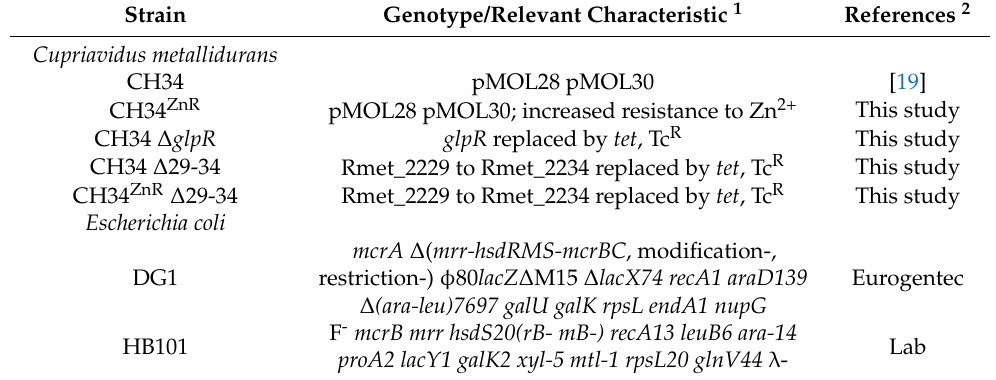
Table 1. Strains used in this study.